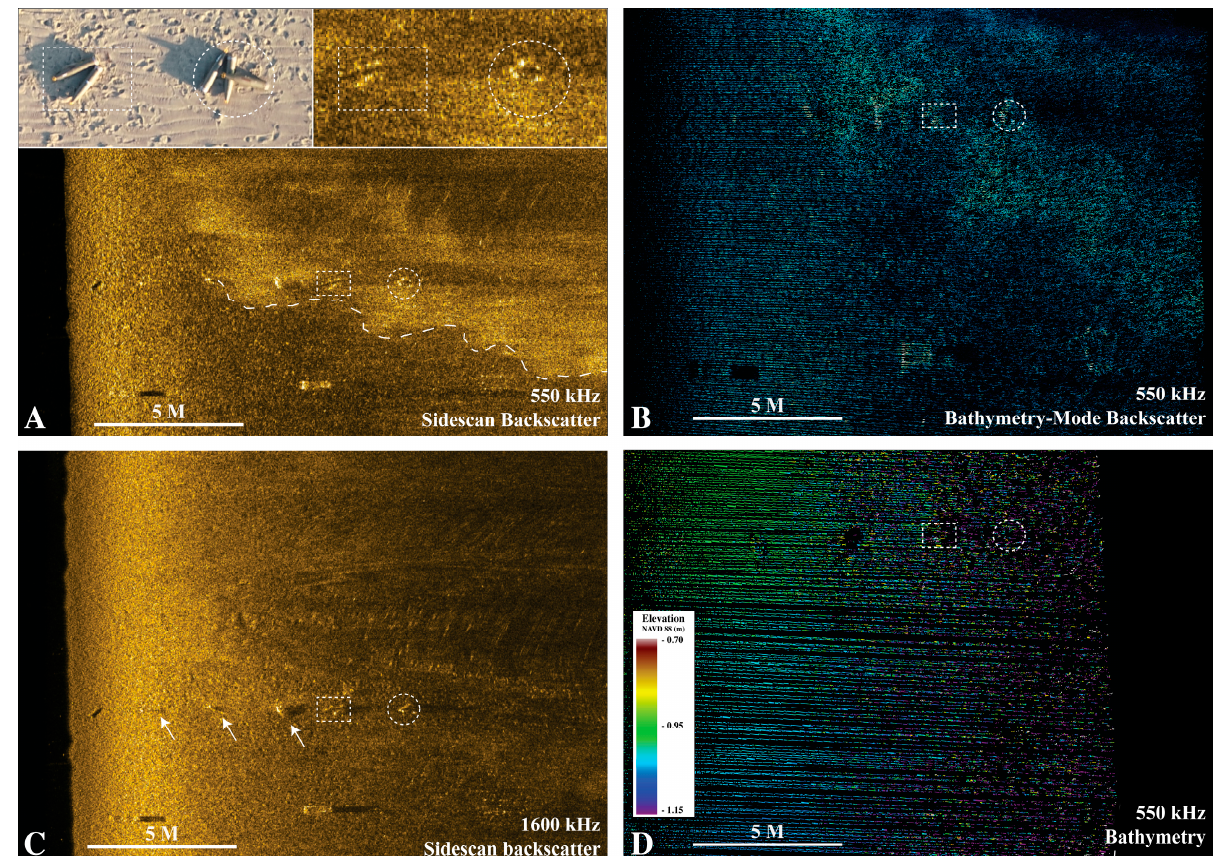
Figure 3. Starboard channel of the four data types from a phase-measuring sidescan sonar from Site 1, a sandy intertidal flat. ( A ) Raw, low frequency sidescan backscatter, black vertical bar to left of image is ‘water column’ from sidescan waterfall. Note the dashed line, highlighting a different bottom reflector also seen in ( B ), but not ( C ) or ( D ). Upper left inset is from UAS image. Upper right inset is zoom of rectangle and circle from waterfall below. ( B ) Bathymetry-mode backscatter. ( C ) Raw, high frequency sidescan backscatter. ( D ) Swath bathymetry, note the bottom coverage is not as extensive away from